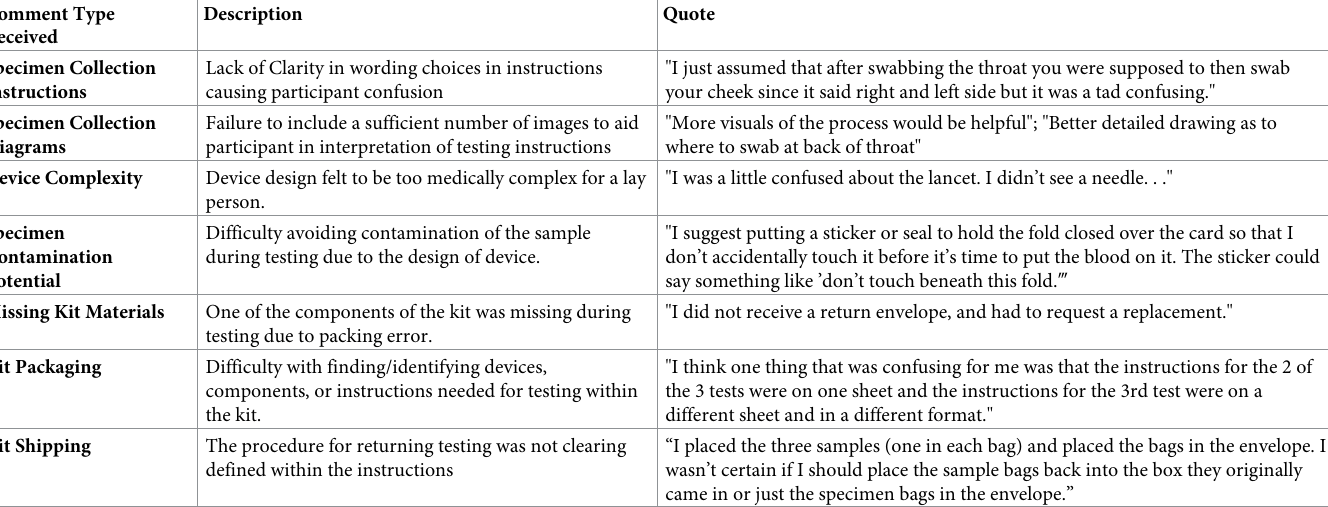
Table 2. Themes of observations from participants after self-collecting saliva, oropharyngeal swabs and dried blood spot cards for SARS-CoV-2-related testing, United States, April